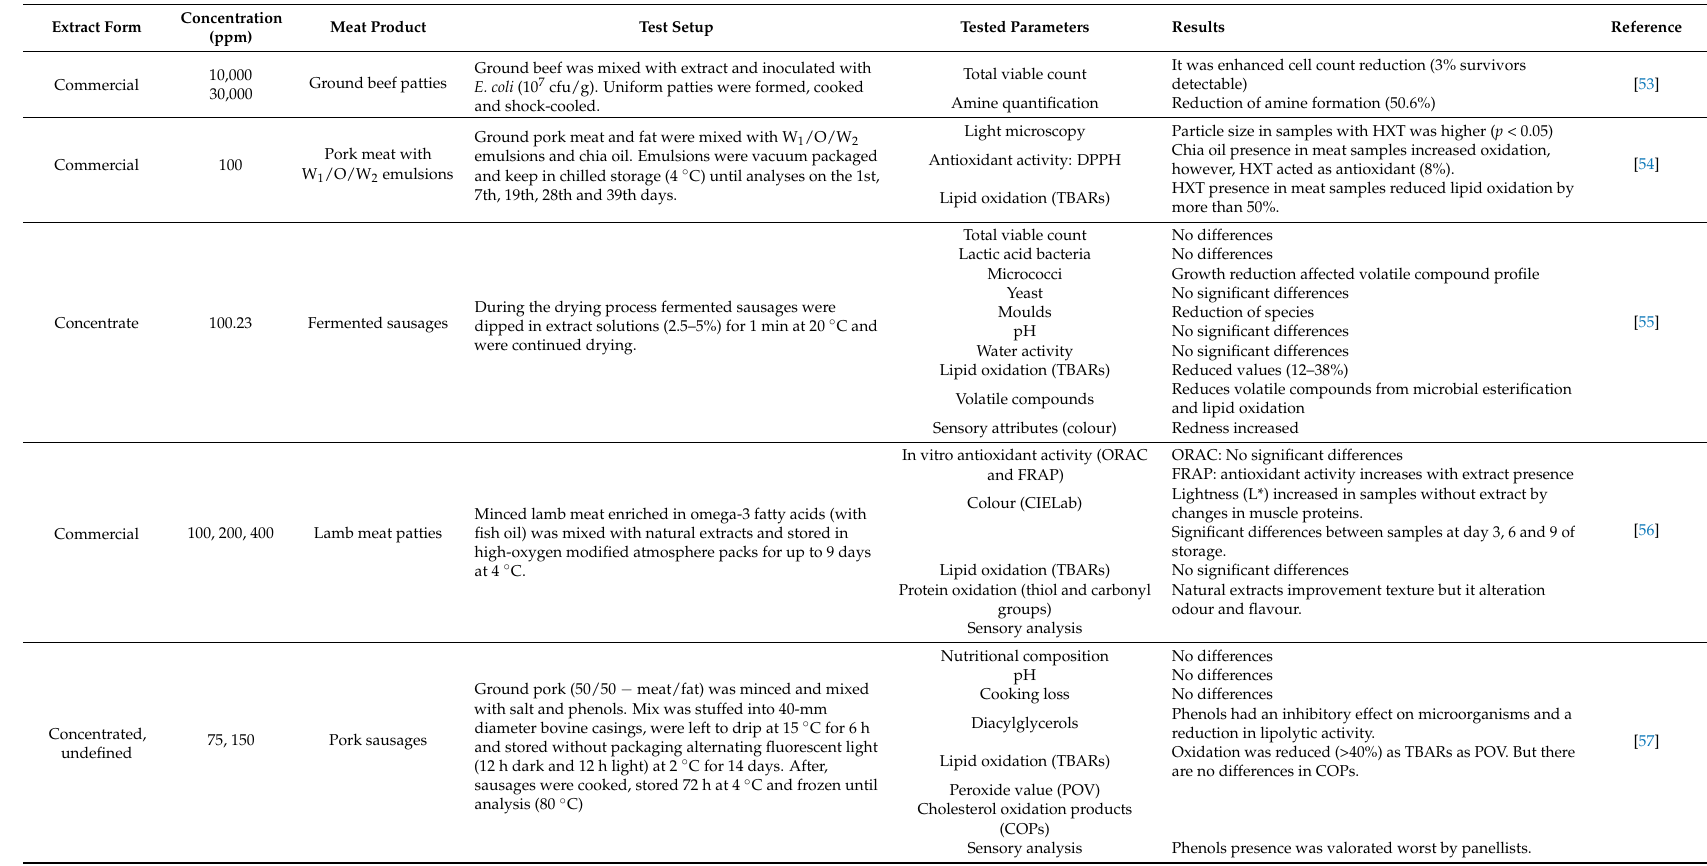
Table 1. Results on the applicability of HXT on meat and its effect on product